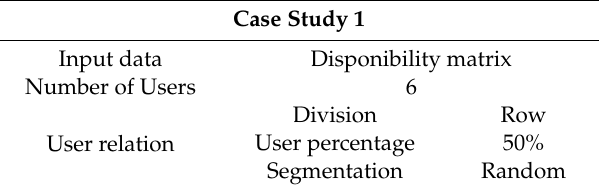
Table 7. Example of a collaborative model adjustment—Case Study 1.